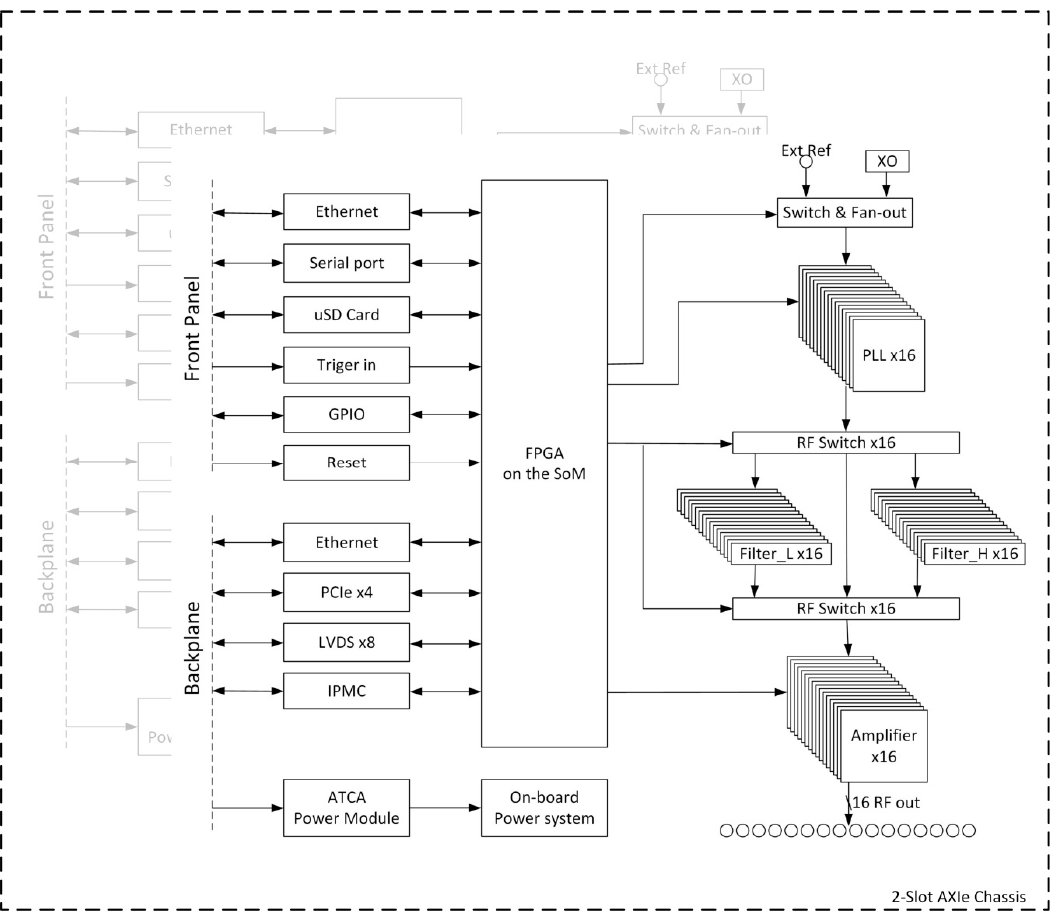
Figure 6. System block diagram of the 32-channel RF signal generator. Two 16-channel AXIe RF signal synthesizer modules were installed into a 2-slot AXIe chassis to form a 32-channel RF signal generator. The modules communicate with each other through the backplane LVDS connections. The chassis provides power to the modules through its